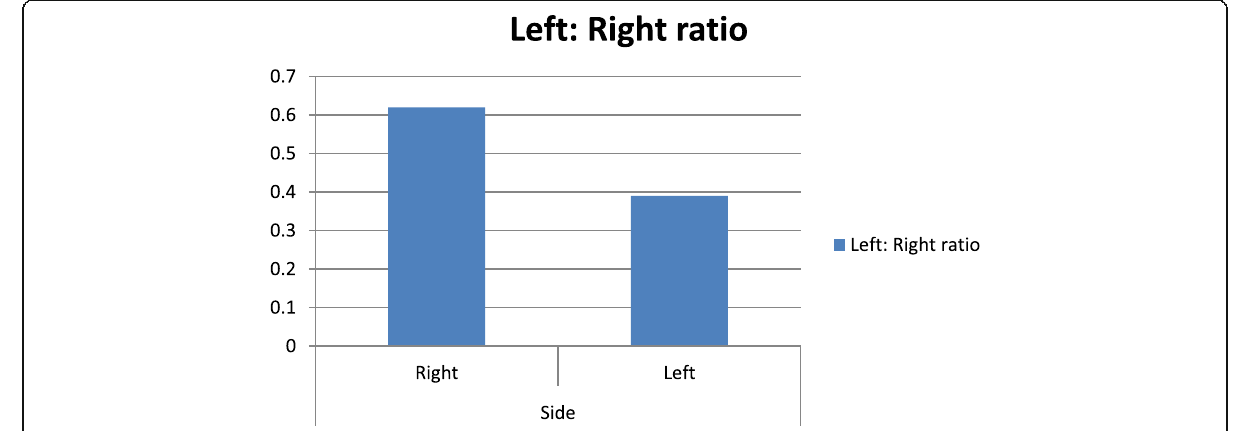
Fig. 8 Relation between left:right ratio of ICWs of SPD-CAT and lesion side of stroke